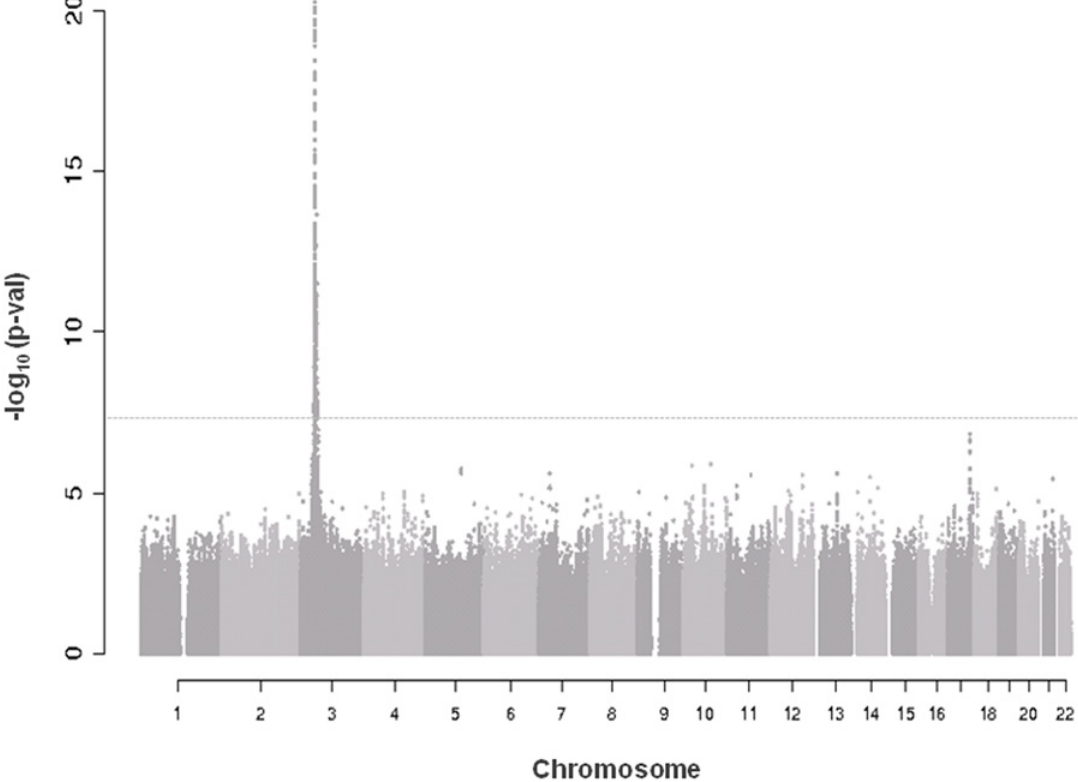
Fig 1. Manhattan plot of genome-wide association results in discovery analysis. Truncated Manhattan Plot showing -log 10 (p-values) for all SNPs of the CRIPTO discovery GWAS ordered by their chromosomal position. The dashed horizontal line represents the threshold for genome-wide significance (p-value < 5 * 10 -8 ). SNPs associated at the genome-wide significance level are all located on chromosome 3 (lowest p-value = 1.03 * 10 – 159